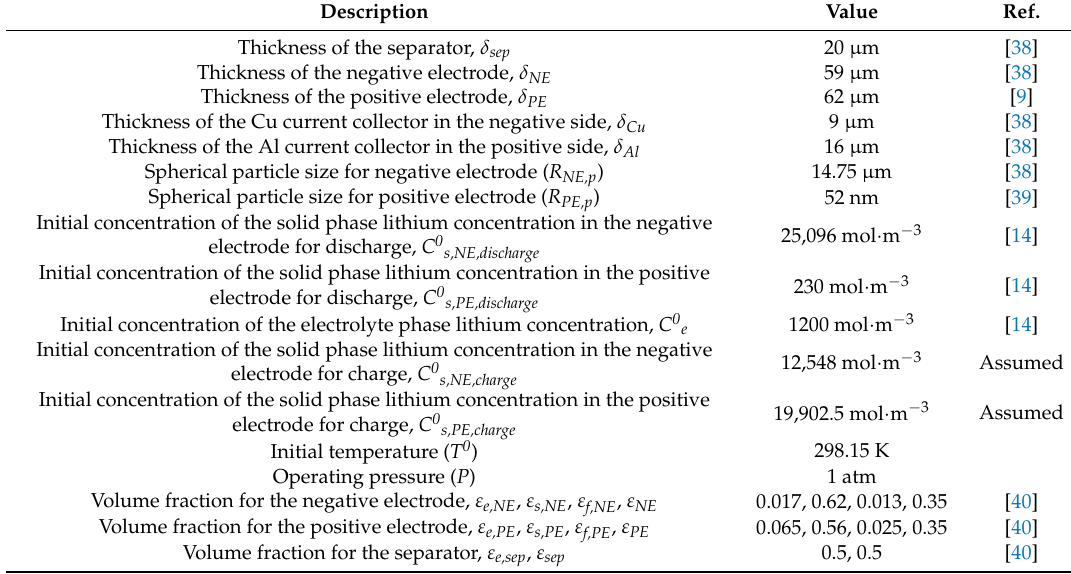
Table 1. Geometric, initial, and operating conditions.